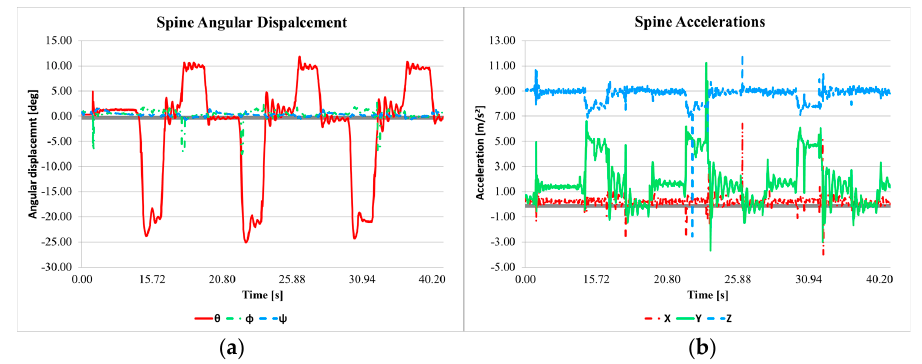
Figure 6. Acquired data from the IMU sensor during the test in Figure 5: ( a ) angular displacements; ( b ) accelerations.